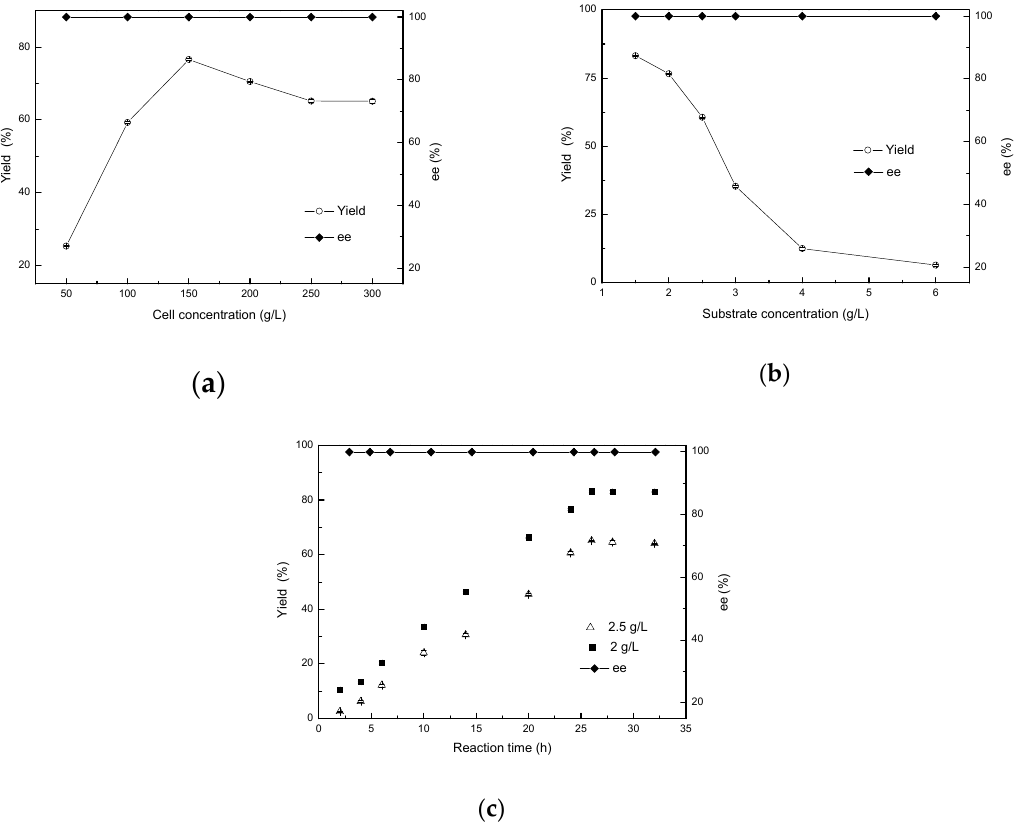
Figure 7. Effects of cell concentration ( a ), substrate concentration ( b ), and reaction time ( c ) on the asymmetric reduction.